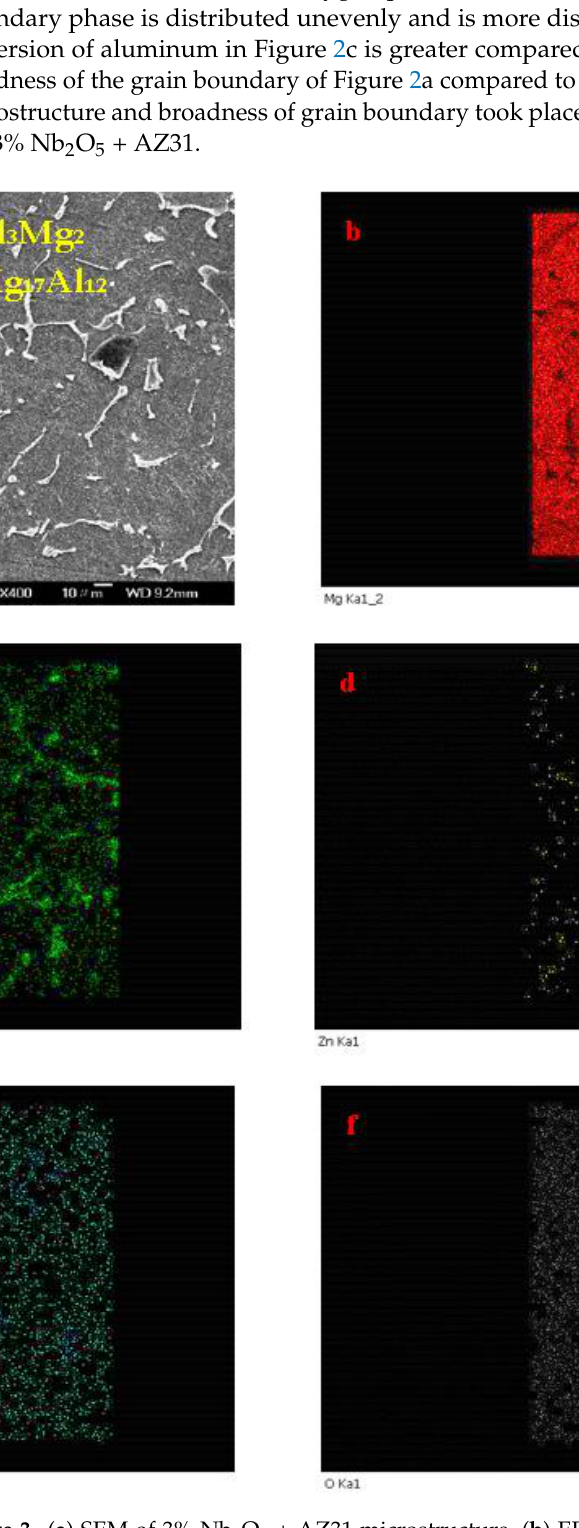
Figure 3 . ( a ) SEM of 3% Nb 2 O 5 + AZ31 microstructure, ( b ) EDS shows Mg distribution, ( c ) EDS shows Al distribution, ( d ) EDS shows Zn distribution, ( e ) EDS shows Nb distribution, ( f ) EDS shows O distribution.